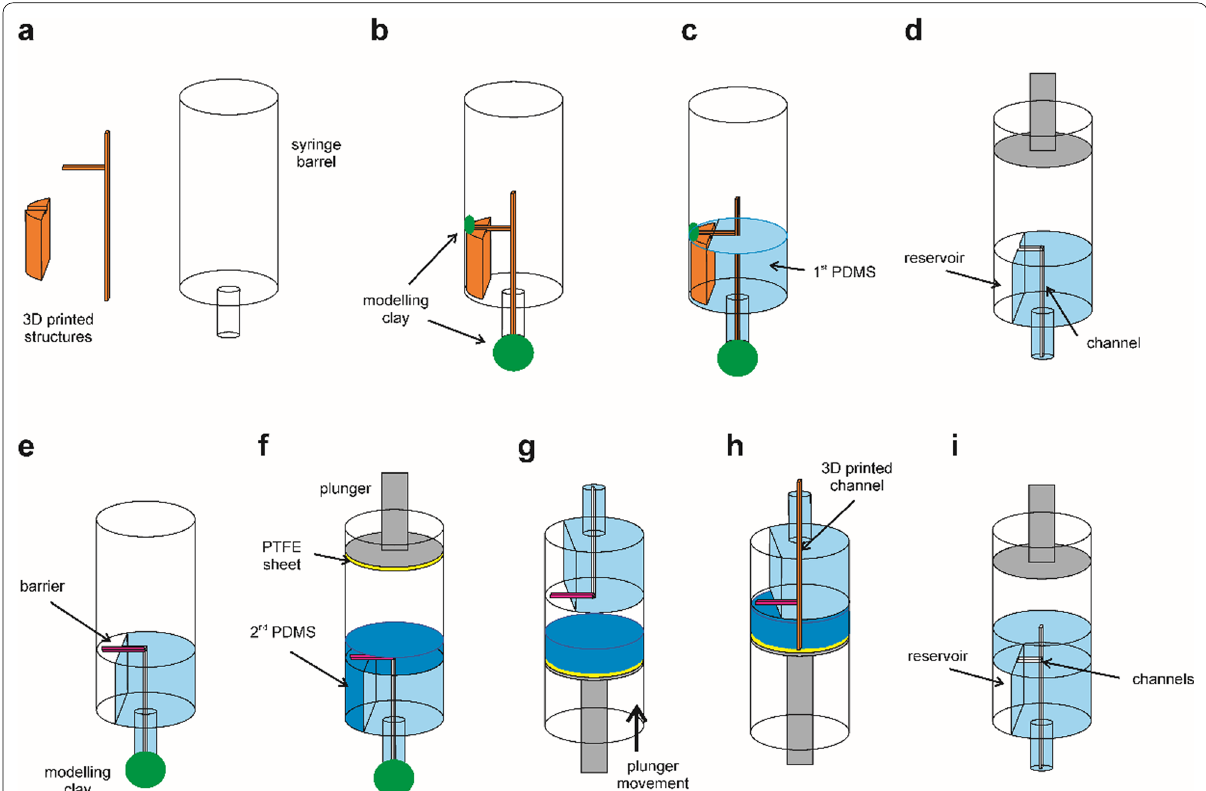
Fig. 2 Scheme of the preparation of the LIS